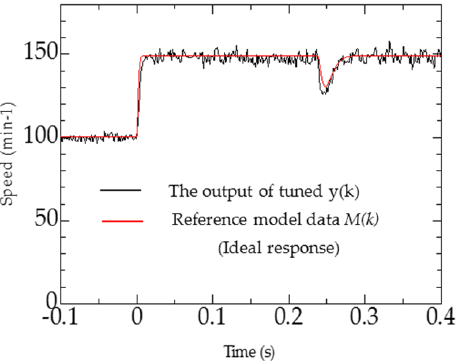
Figure 11. Output results when tuned PI ‐ P gains were applied using FRIT.